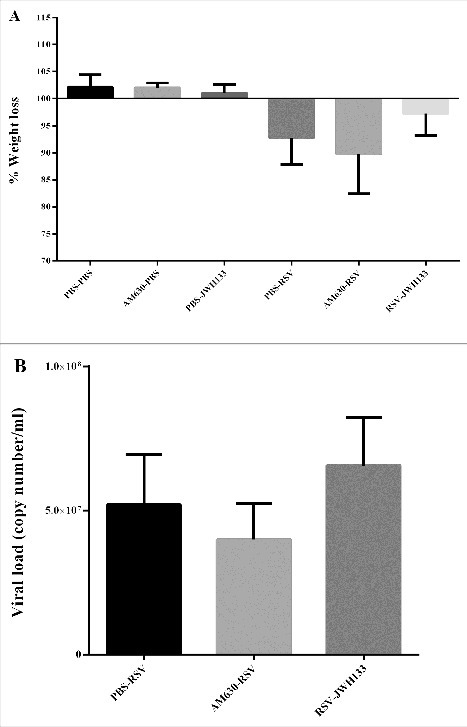
The effect of CB2 receptors on mice weight loss and viral load following RSV infection. (A) The graph shows changes in body weight 5 days after the primary RSV or mock infection. (B) CB2 receptors were blockade via using AM630 or activated through JWH133 daily and RSV copy number was determined by quantitative real-time polymerase chain reaction in BAL supernatant on day 5 after infection. Results represent the mean ±SEM of 6 animals for each group.